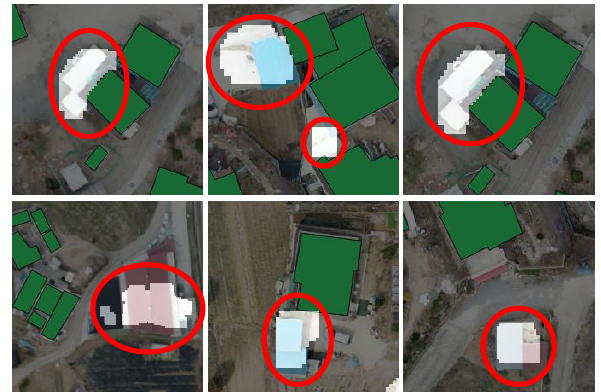
Figure 15. Example of unregistered buildings and extended buildings that our system detected